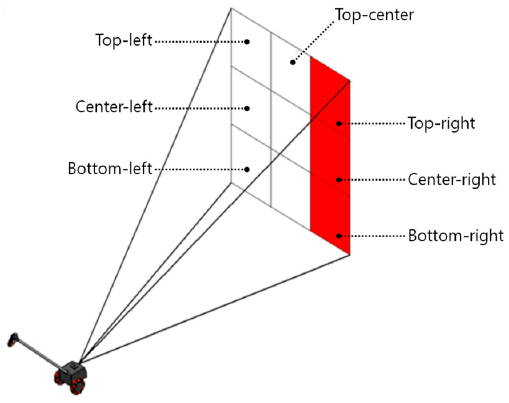
Figure 4. Division of the front area.